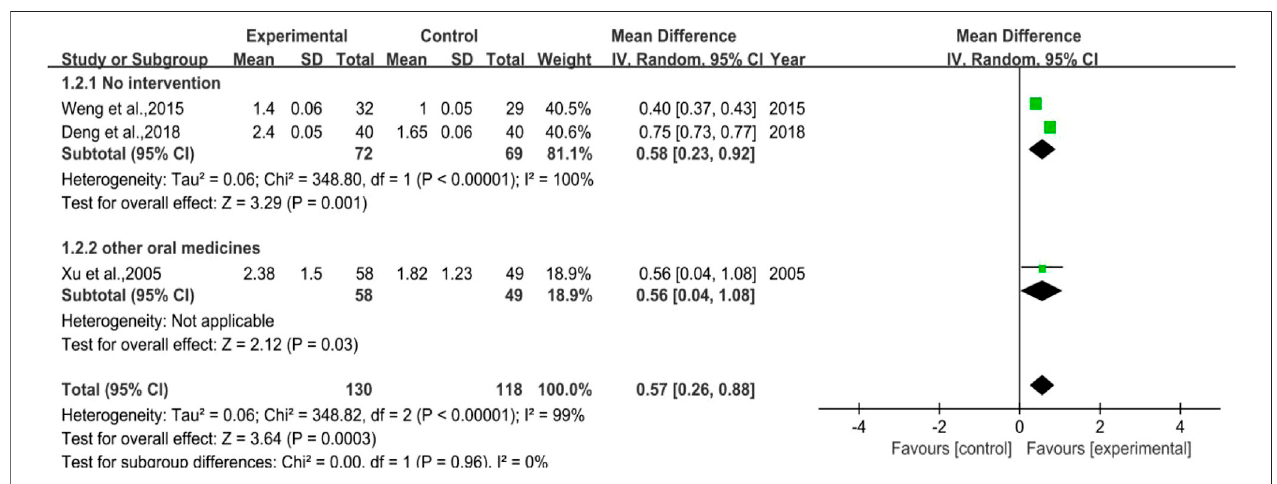
FIGURE 4 | The forest plot of neutrophil count in preventive medication.